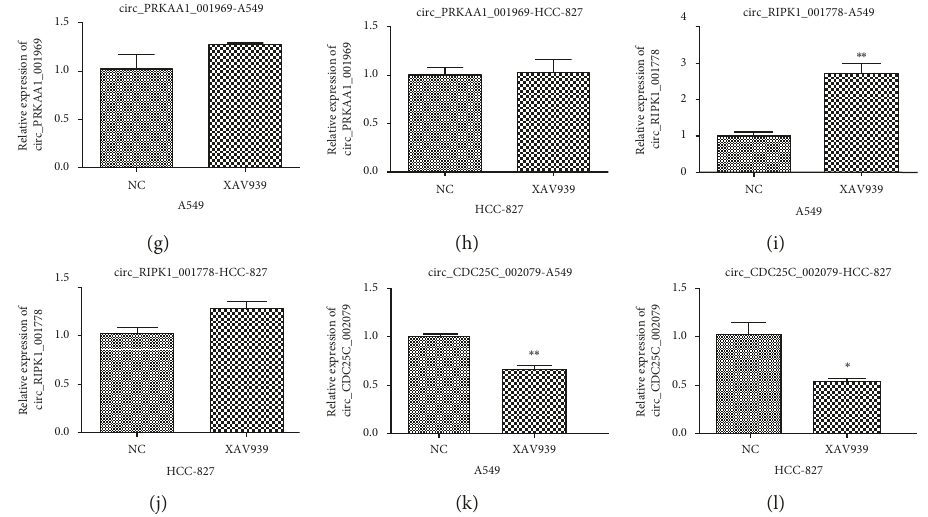
Figure 6: The relative expressions of key DE-circRNAs in the A549 and HCC-827 cells. NC represents the control cells. XAV939 represents the A549 and HCC-827 cells treated by 10 μ M XAV939. ∗ P < 0 . 05 indicates a significant difference compared with that of the NC group; ∗∗ P < 0 . 01 indicates a very significant difference compared with that of the NC group; ∗∗∗ P < 0 .